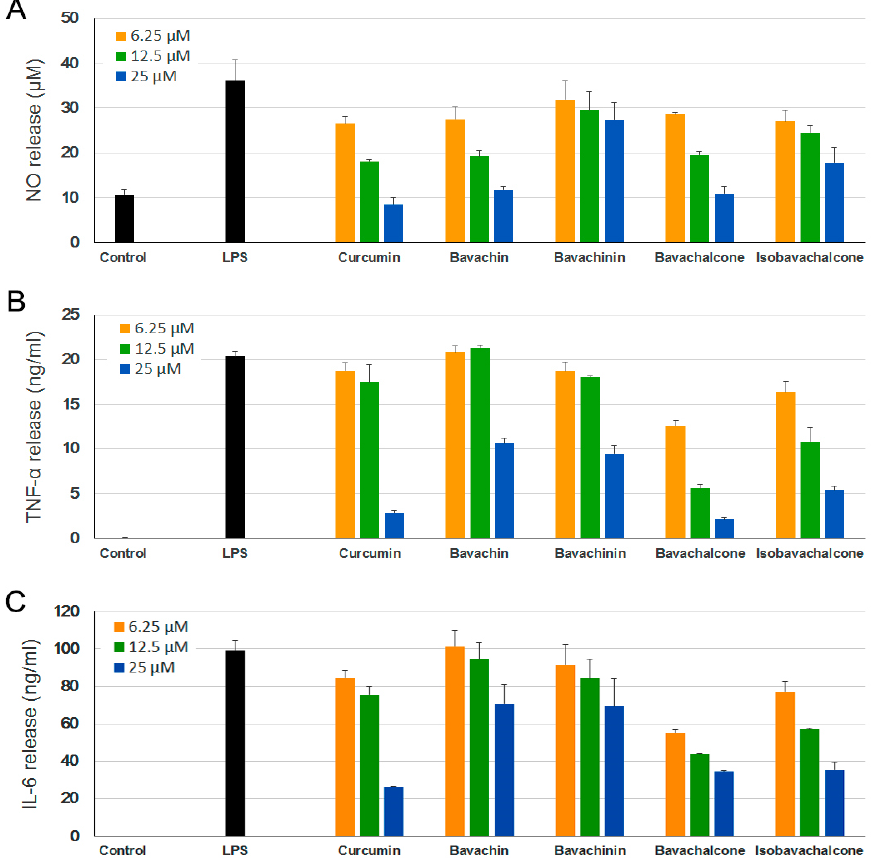
Figure 2. Anti-neuroinflammatory effects of Psoralea Fructus (PF) compounds. BV-2 cells were incubated with different concentrations of PF compounds for 1 h followed by treatment with 0.5 µg/mL lipopolysaccharide (LPS) for 24 h. The culture supernatant was aliquoted. ( A ) Nitric oxide (NO) levels were determined using Griess reaction; ( B ) Tumor necrosis factor (TNF)- α and ( C ) interleukin (IL)-6 levels were measured using ELISA. Curcumin was used as a positive control. Data are expressed as mean ± SEM.